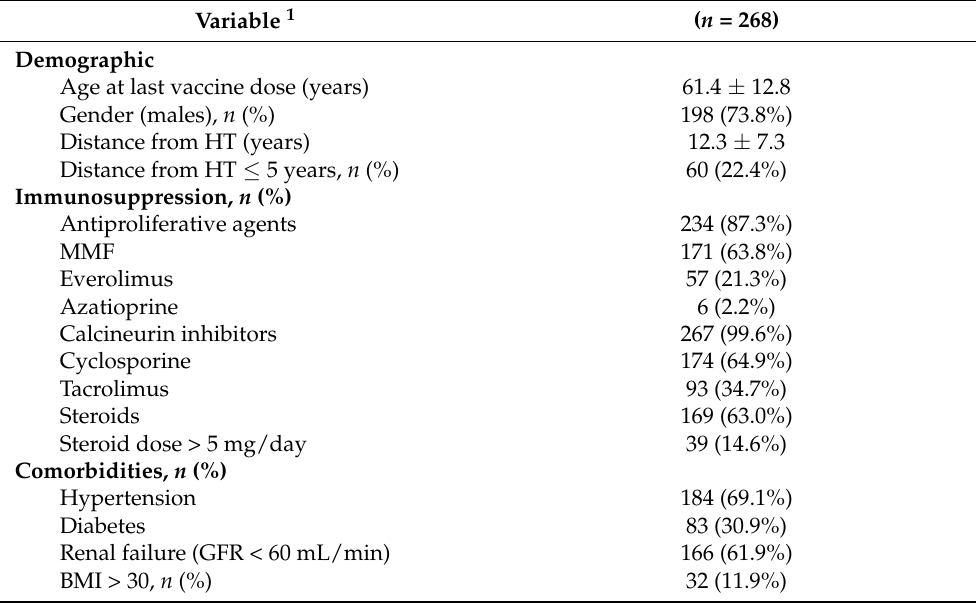
Table 1. Characteristics of the study